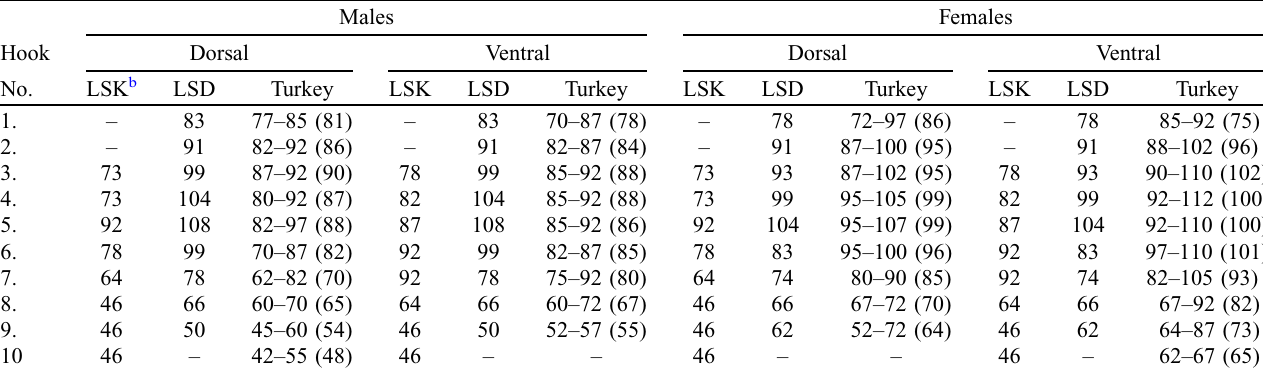
Table 2. Measurements of the proboscis hook blades of Echinorhynchus baeri from Lake Sevan and from Turkey. a